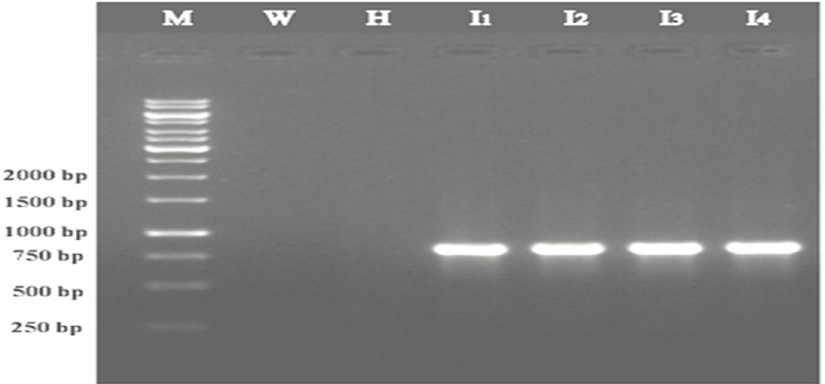
Figure 1. Agarose gel showing PCR amplification of the CP gene of ToLCNDV-Rg infecting the ridge gourd. Lane M: 1 kb molecular marker; Lane W: Water control; Lane H: Healthy sample; Lane I 1 , I 2 , I 3 , and I 4 : Infected ridge gourd samples.